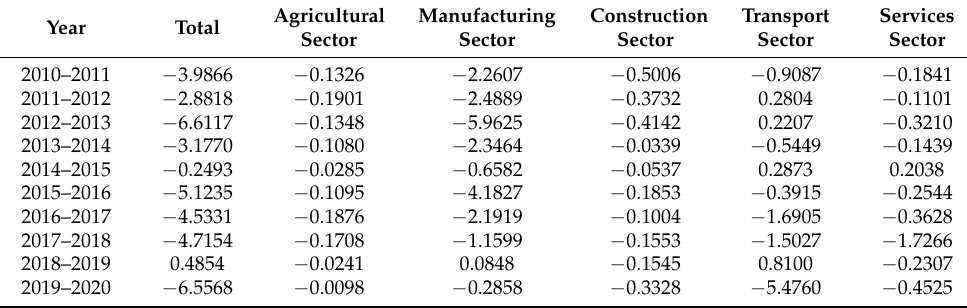
Table 4. The annual contribution of energy intensity of different sectors to carbon emissions.